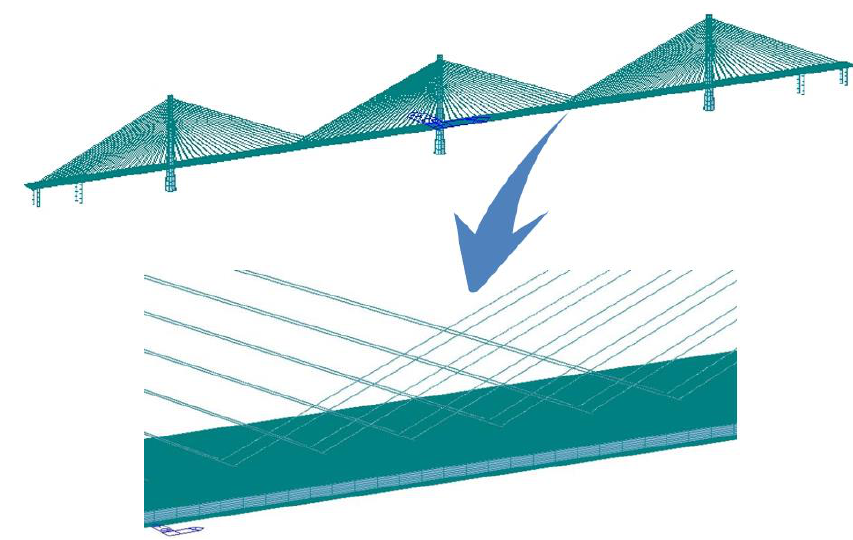
Figure 2. Crossed-cable model details.